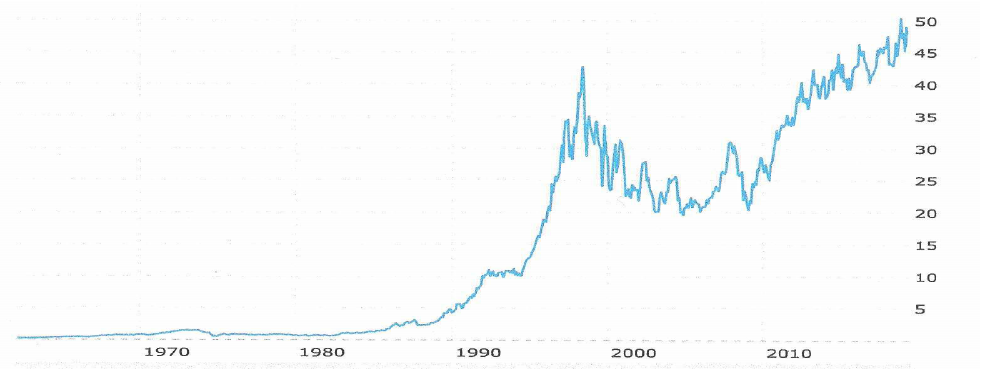
Figure 1: The Coca-Cola Company. 57 Year Stock Price History